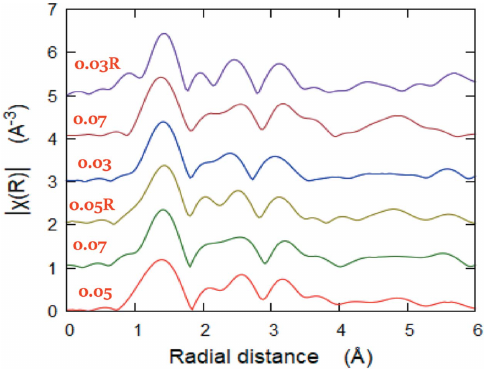
Figure 10 k 2 -weighted EXAFS oscillations of Mn-doped ZnO samples at the Mn K - edge, shifted and arranged vertically according to their FT amplitudes.